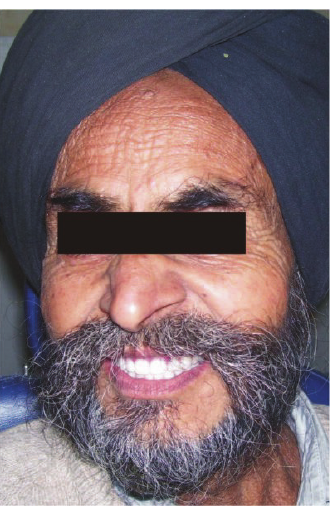
Figure 6: Postoperative